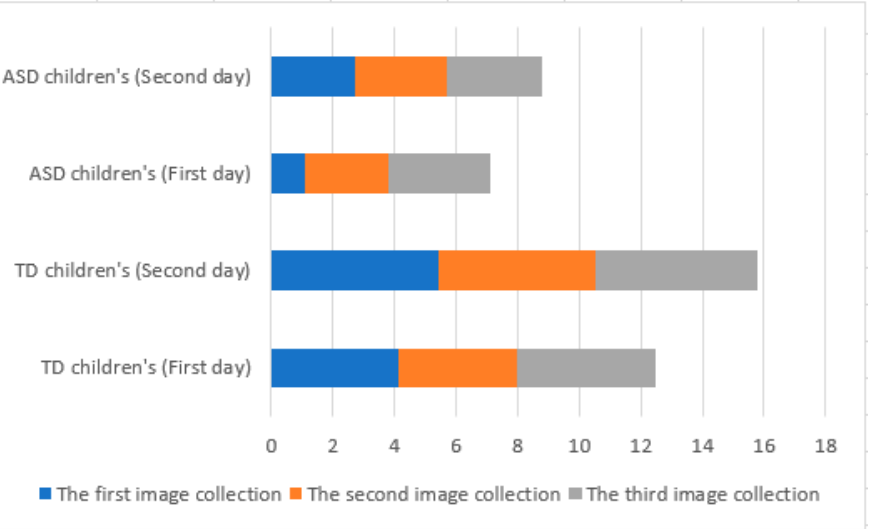
Figure 12. Comparison of the performance (correct answers) of the two groups on the first and second day .